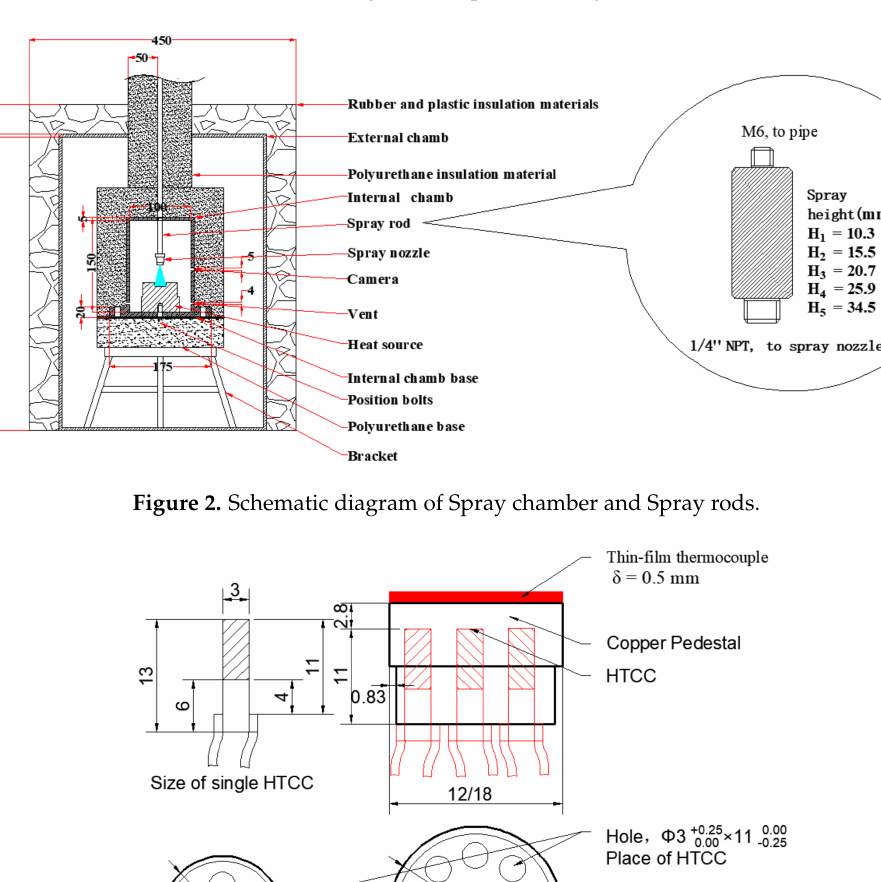
Figure 1. Schematic diagram of experimental system.